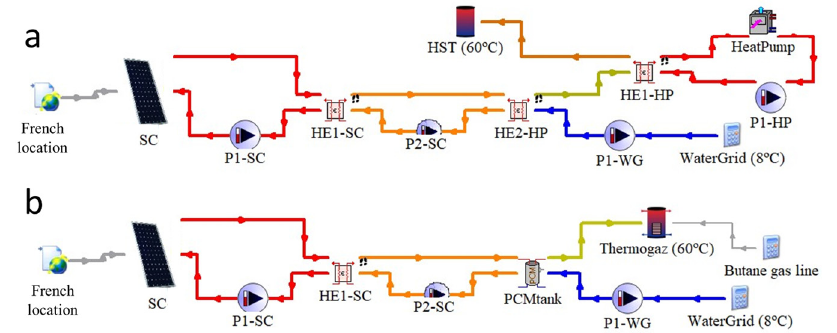
Figure 8. Solar integration configuration based on the preheating of the water from the grid to re- duce ( a ) the energy consumption of the heat pump; ( b ) the fuel consumption in the Thermigaz tank, including PCM cartridges in the HST to modulate the tank temperature and increase heat storage